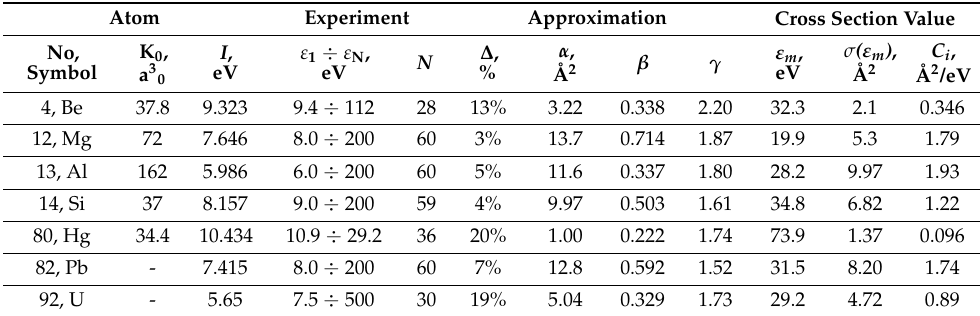
Table 4. Characteristics of atoms of some metals, error and parameters of approximation, general characteristics of cross sections according to the found approximations.